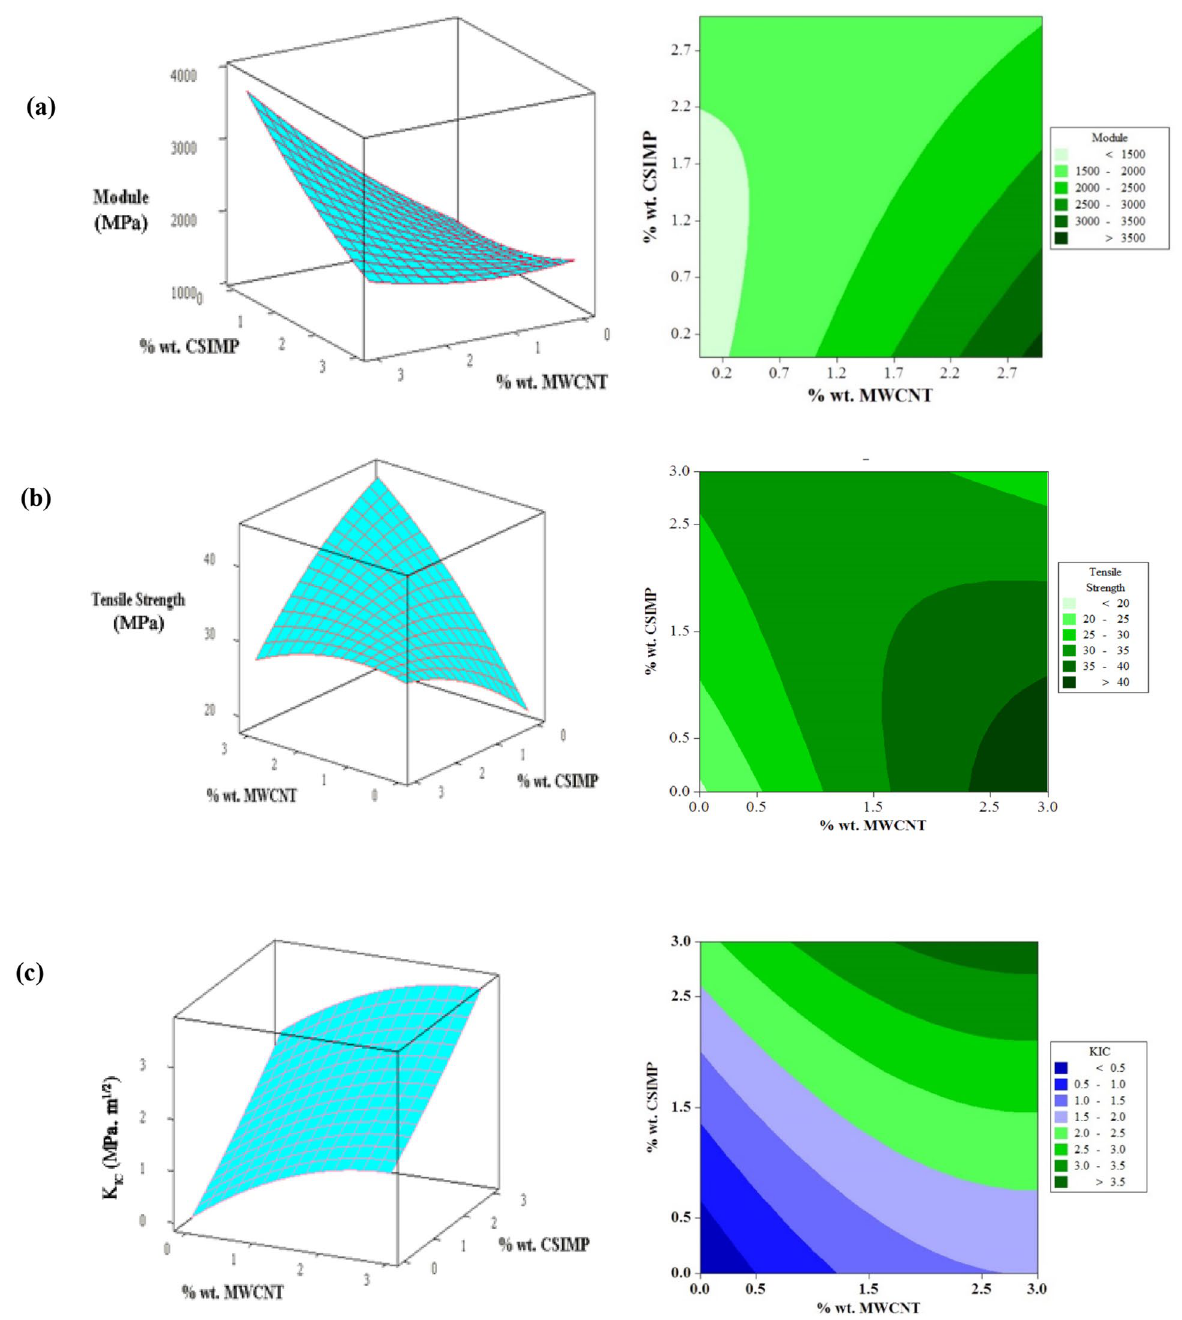
Figure 4. Response surface and Contour plots of tensile properties and toughness of epoxy